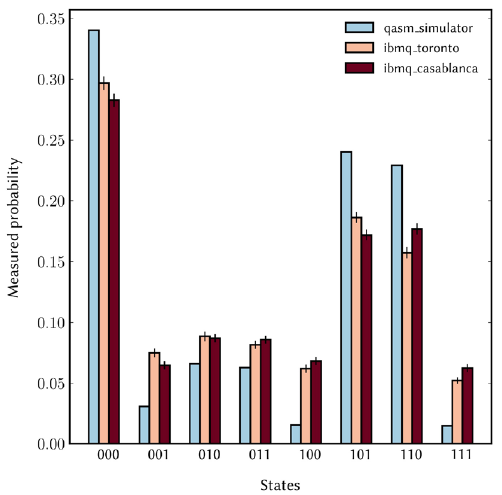
Figure 7. Results of the complete quantum order-finding routine for N = 21 and a = 4. On each processor, the circuit was executed 8192 × 100 times with measurement error mitigation. The error bars represent 95% confidence intervals around the mean value of each histogram bin (see Supplementary information IV). The simulator probabilities show the ideal